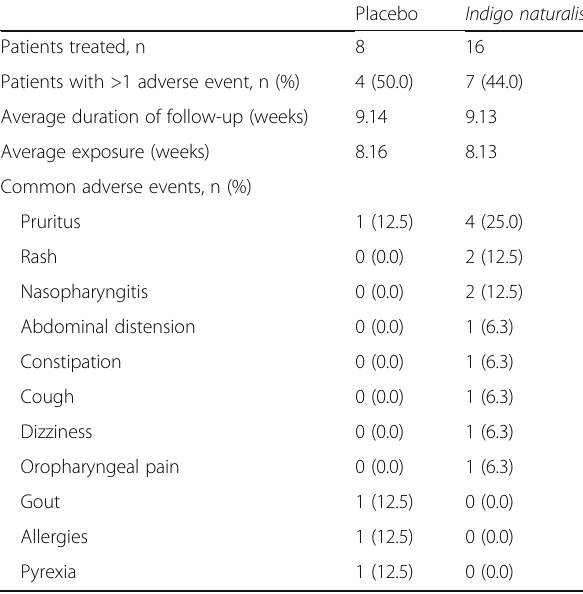
Table 2 Patient safety data through week 9